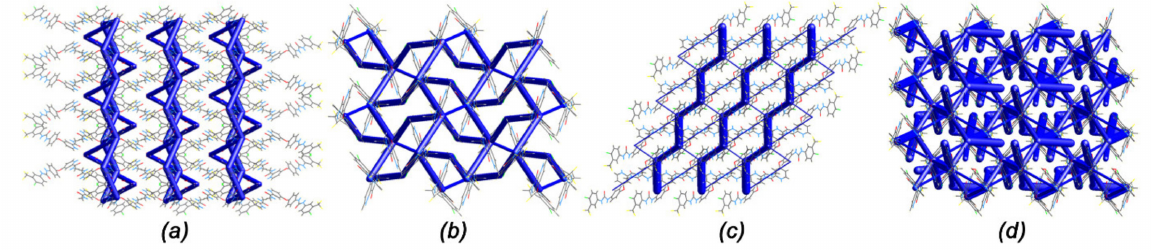
Figure 8. Energy frameworks for the crystal structures of ( a ) (I), ( b ) (II), ( c ) (IV) and ( d ) (V) view down [001] direction. The energy scale factor is 150, and interaction energies with magnitudes smaller than 10 kJ · mol − 1 have been omitted.